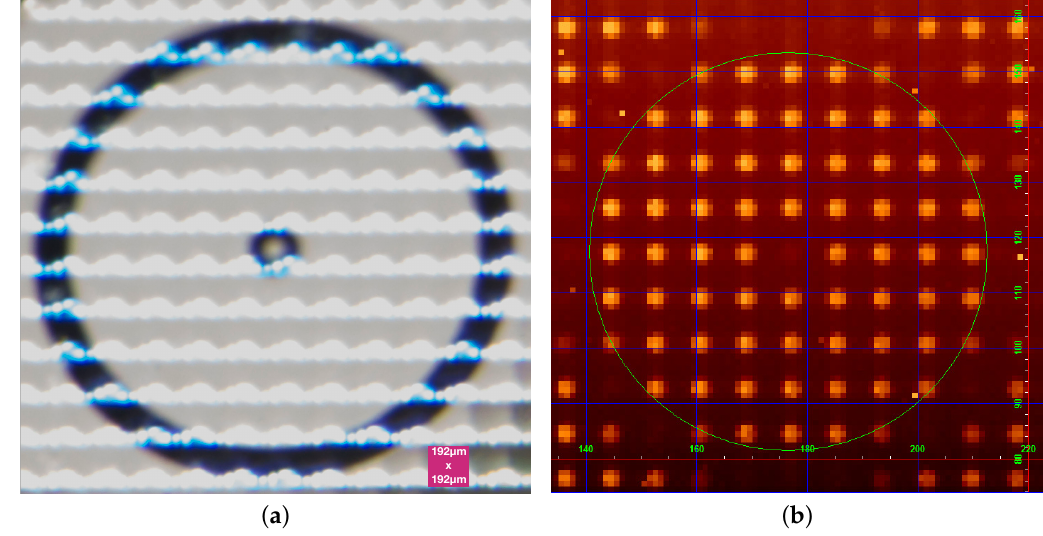
( b ) Figure 31: Zoomed image of the detector with lenslet array, Bias 11.53V, itime = 5ms, CDS Figure 4. CIAO lenslet design and footprint on the detector. See text for details. ( a ) Microscopic image of a CIAO lenslet array with “blue” light reflecting chromium masks, defining the pupil boundaries. The scale is indicated by the red square; ( b ) Footprint of the illuminated CIAO lenslet on the Saphira detector. Green circle diameter: